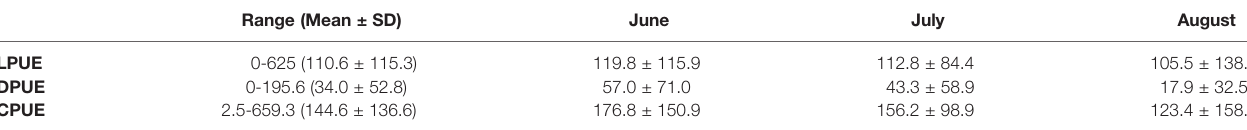
TABLE 1 | Range and monthly means (± SD) of Landings Per Unit of Effort (LPUE), Depredation Per Unit of Effort (DPUE), and Catch Per Unit of Effort (CPUE) during the 3-month survey in 2018.